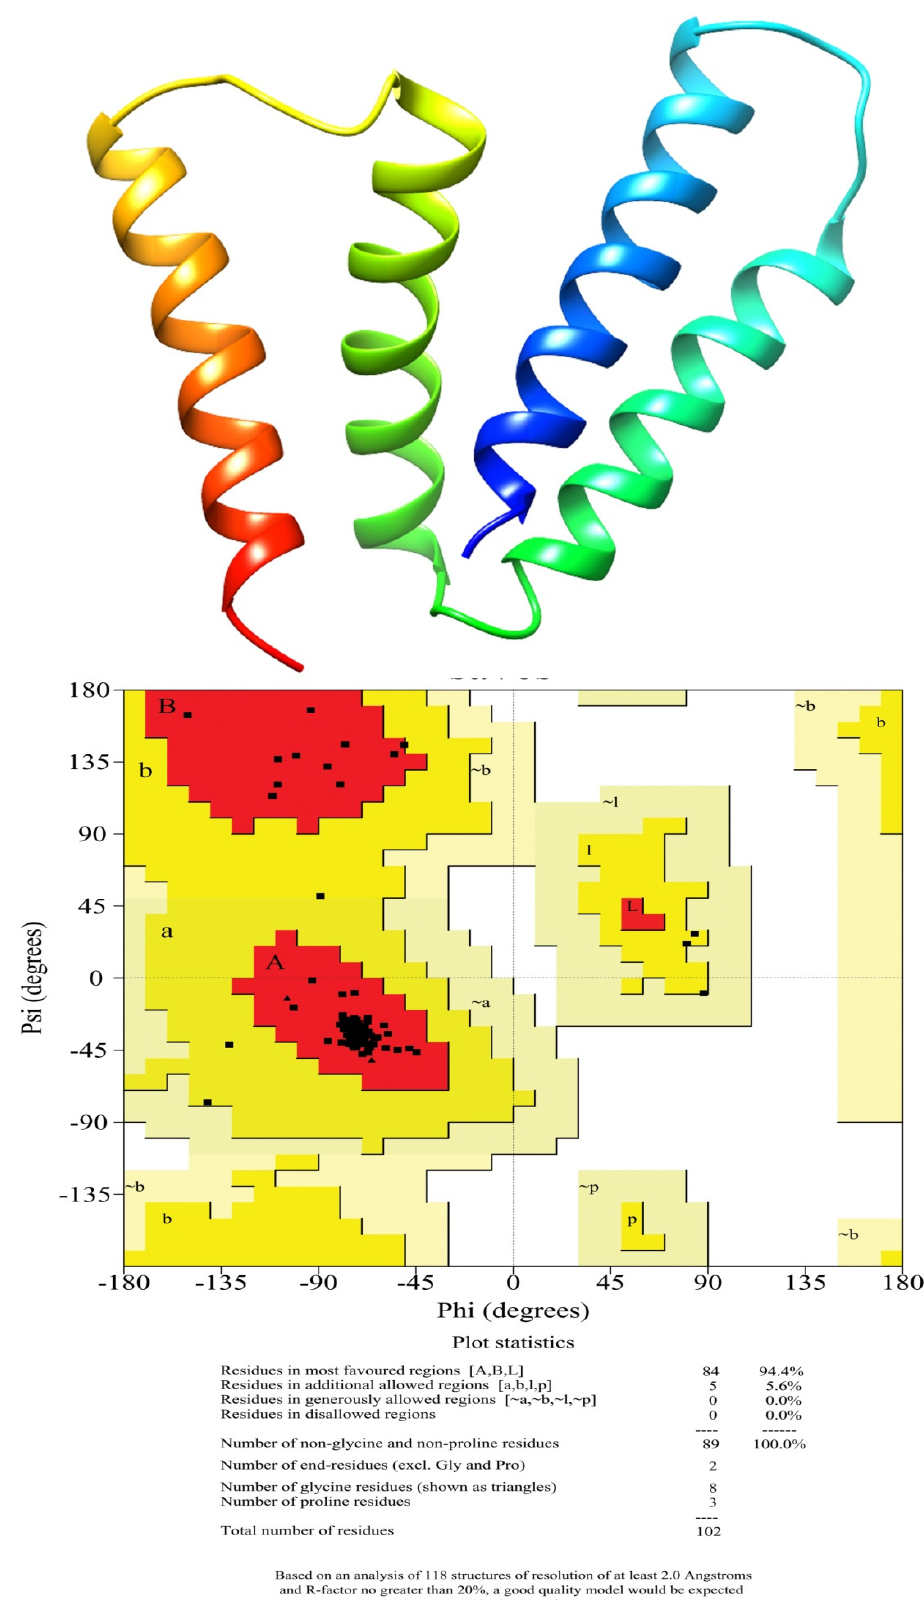
Figure 2. Homology model of the MDR efflux protein of A. baumannii (LAC-4) and Ramachandran plot analysis of modelled protein.